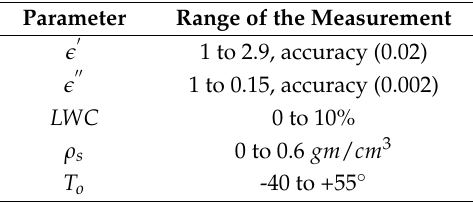
Table 1. Technical specification of the Toikka snow fork instrument: complex dielectric constant of the snow ( (cid:101) (cid:48) + j (cid:101) (cid:48)(cid:48) ), liquid water content ( LWC ), snow density ( ρ s ), and operating temperature range of the instrument ( T o ). Parameter Range of the Measurement (cid:101) (cid:48) 1 to 2.9, accuracy (0.02) (cid:101) (cid:48)(cid:48) 1 to 0.15, accuracy (0.002) LWC 0 to 10% ρ s 0 to 0.6 gm / cm 3 T o -40 to +55